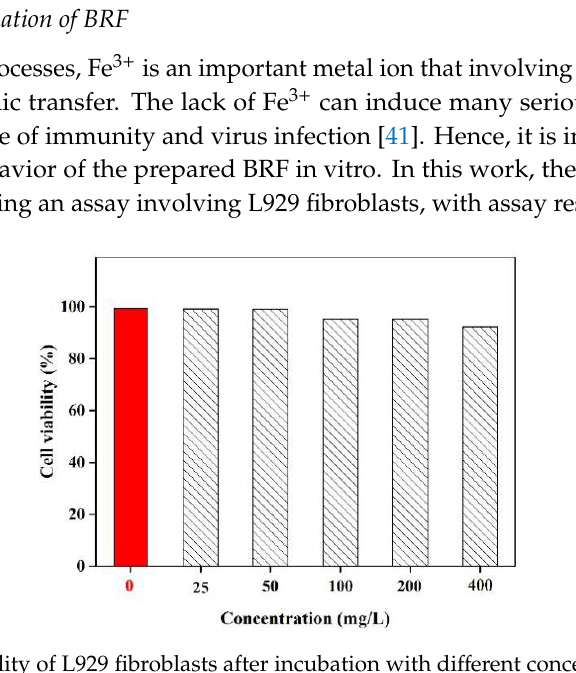
Figure 4. Cell viability of L929 fibroblasts after incubation with different concentrations of BRF.